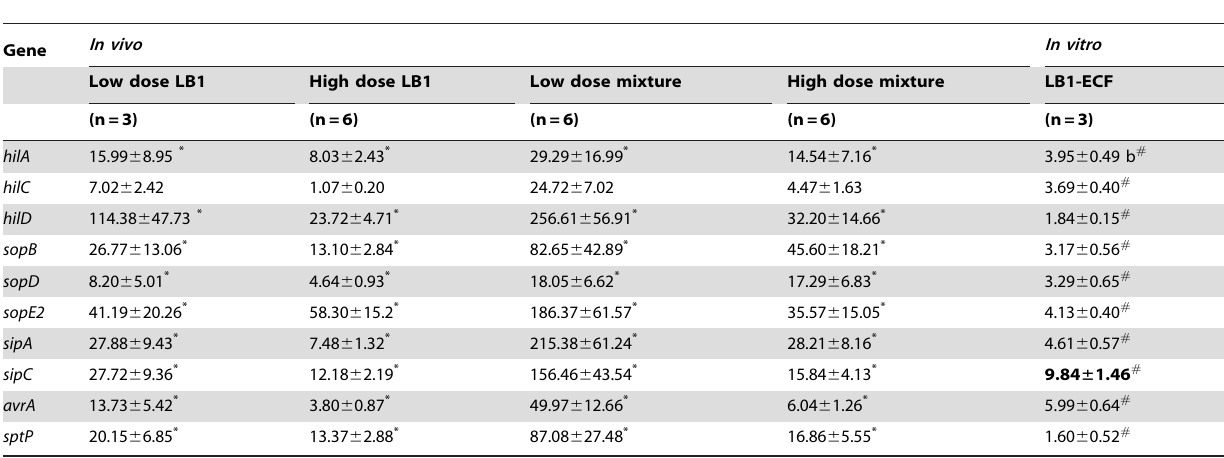
Table 7. Fold decrease in virulence gene expression of Salmonella in vivo and in vitro a .